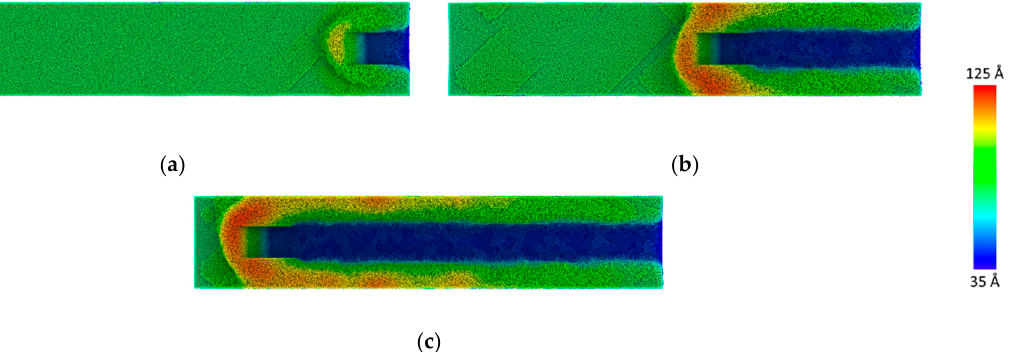
Figure 2. Material pile ‐ up at ( a ) 120 ps, ( b ) 360 ps, and ( c ) 660 ps.